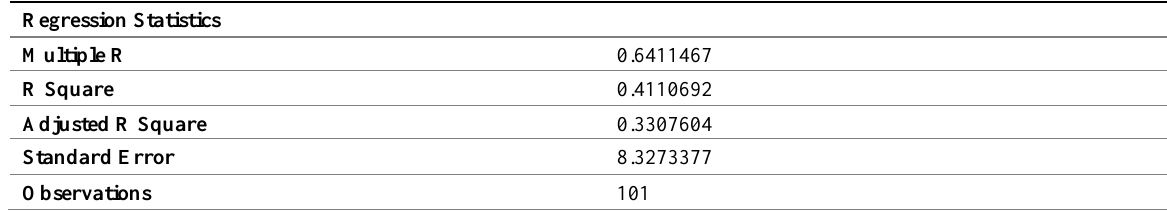
Table 7: Regression Statistics (Chittagong Division)